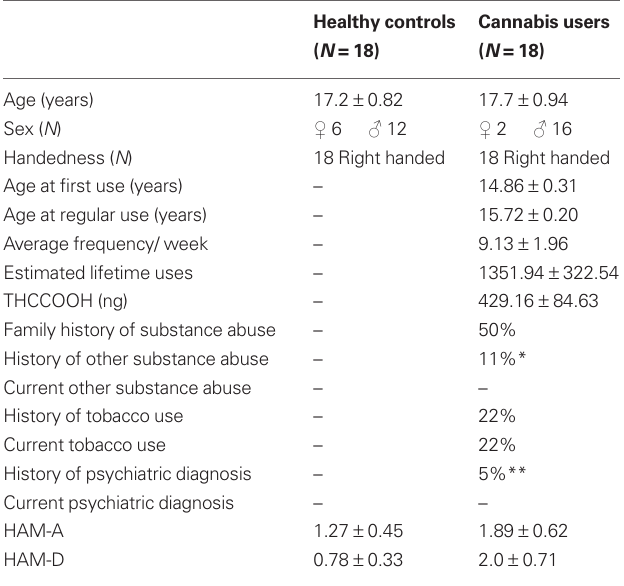
Table 1 | Demographic and clinical description of subject sample.